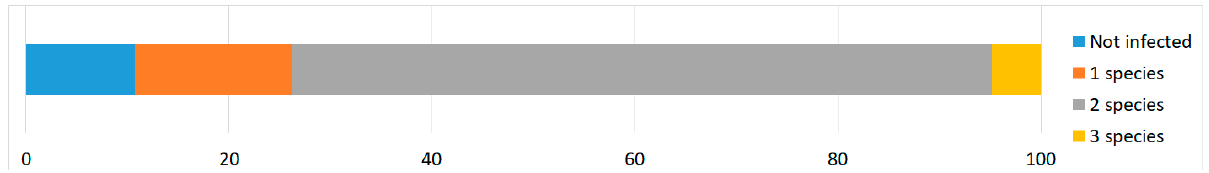
Figure 3. Distribution of the number of Sarcocystis spp. identified in the examined samples of mustelids.